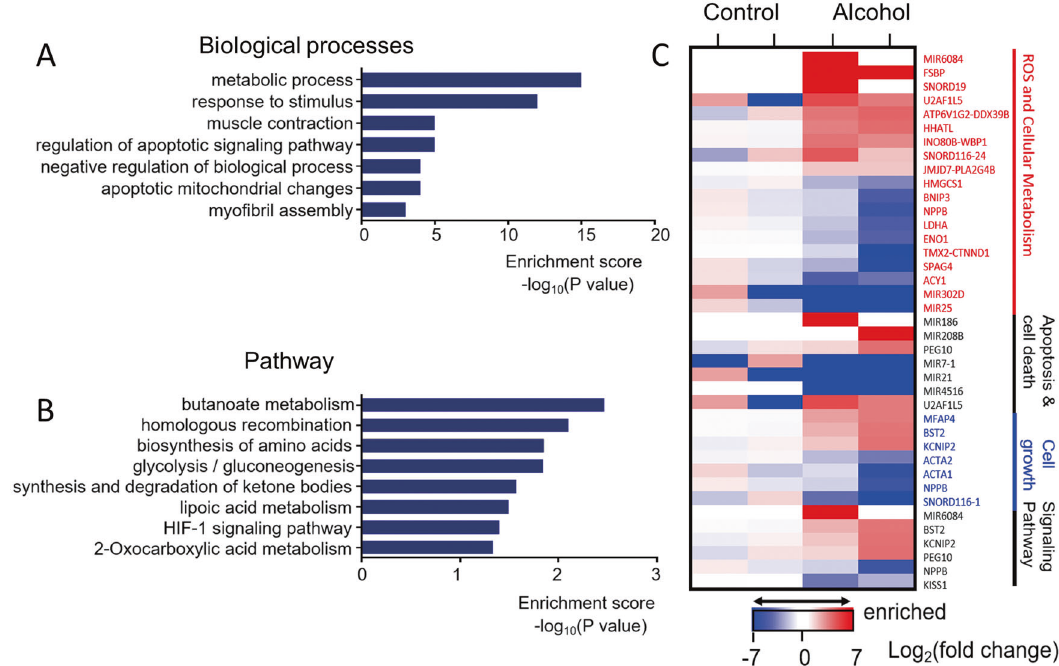
Fig. 3 Alcohol-induced changes in the global gene expression pro fi les of cardiomyocytes. A The enriched terms GO (correlated P value of ≤ 0.05) of 100 mM alcohol treatment compared with vehicle. B The pathway analysis between the control and hiPSC-CMs treated with 100 mM alcohol is listed ( P value of ≤ 0.05). C The heatmap of 39 differentially expressed RNAs between the 100 mM alcohol group and hiPSC-CMs showing four functional clusters. Each row corresponds to a single differentially expressed gene. Colors ranging from blue to red represent the relative expression levels (Log2(fold change)) of